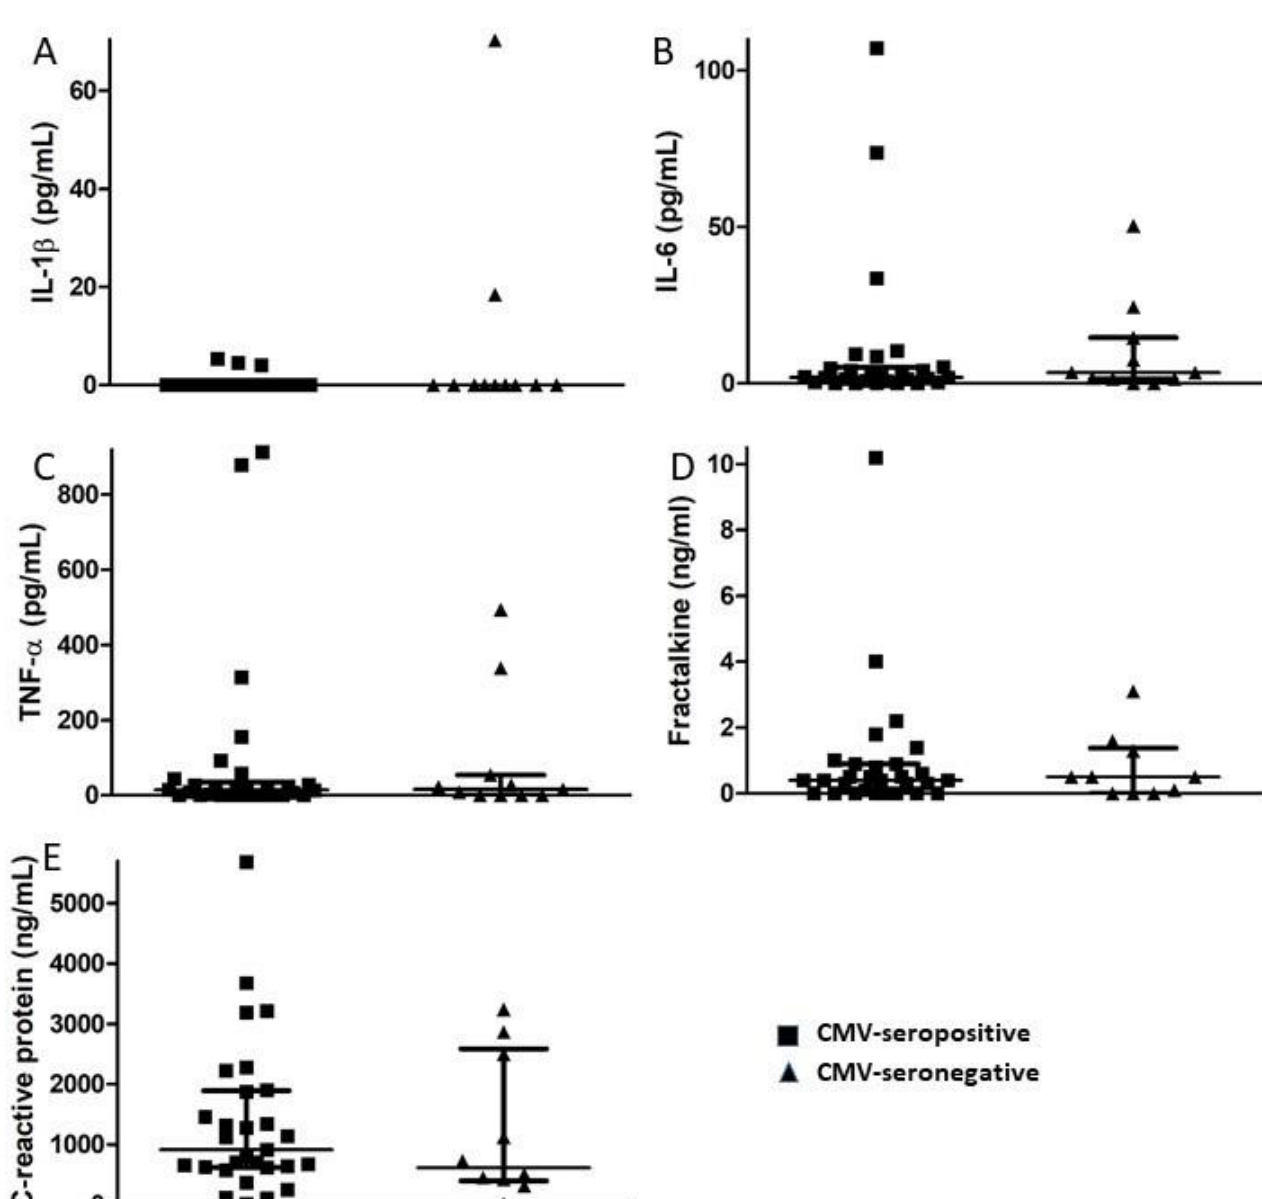
Figure 2. Comparison of plasma levels of inflammatory markers in CMV-seropositive and CMV-seronegative study participants. Plasma levels of the pro-inflammatory cytokines ( A ) IL-1 β , ( B ) IL-6, ( C ) TNF- α , ( D ) the chemokine fractalkine, and ( E ) acute phase protein CRP were measured by ELISA at the time of study entry for each participant and median values compared between CMV-seropositive and CMV-seronegative groups. Error bars on graphs show median ± interquartile range for each group. No significant differences between CMV seropositive and – seronegative groups were observed. Mann – Whitney U -test, ( A ) p = 0.452, ( B ) p = 0.584, ( C ) p = 0.939, ( D ) p = 0.909, ( E ) p = 0.531.